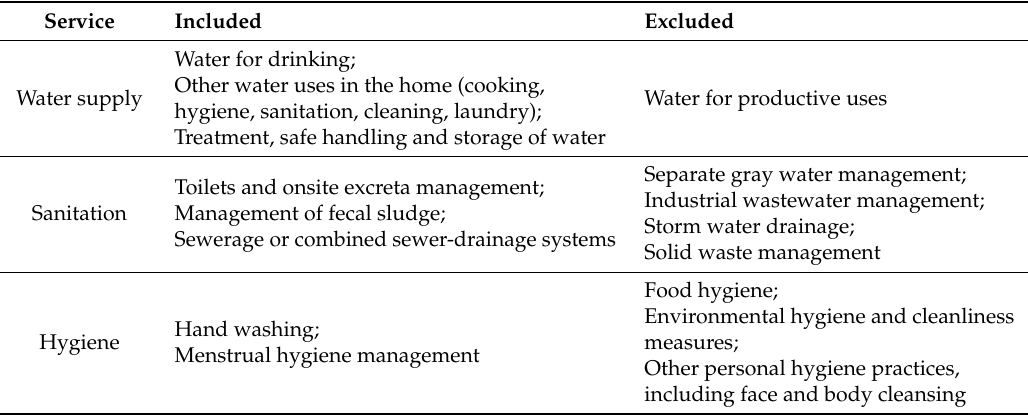
Table 1. Scope of water, sanitation, and hygiene services